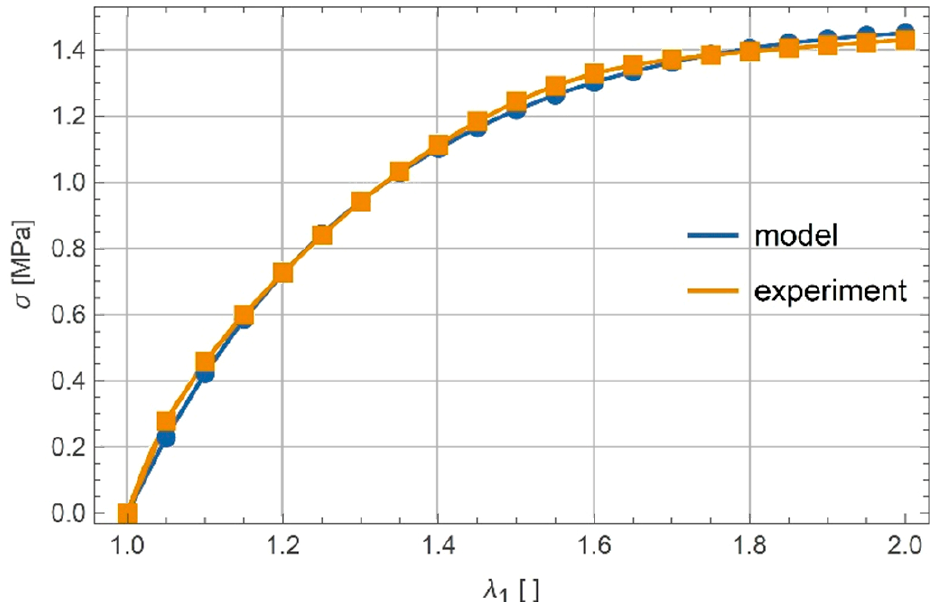
Figure 5. Experimental and calibrated model response for uniaxial tension.